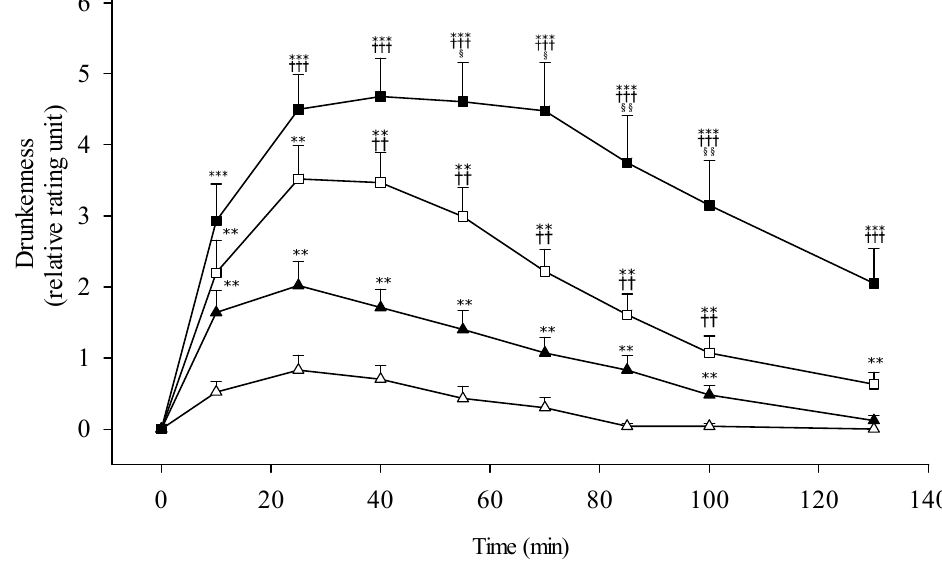
Figure 5. Feelings of drunkenness in nonalcoholic subjects with different ALDH2 allelotypes following different doses of ethanol (0.3 g/kg body weight or 0.5 g/kg). All subjects are ADH1B*2/*2 homozygote. The study groups are denoted as △ , ALDH2*1/*1 with 0.3 g/kg ethanol ( n = 23); ▲ , ALDH2*1/*1 with 0.5 g/kg ethanol ( n = 21); □ , ALDH2*1/*2 with 0.3 g/kg ethanol ( n = 27); ■ , ALDH2*1/*2 with 0.5 g/kg ethanol ( n = 22). Vertical bars (for clarity only the upper or lower portion shown) represent standard errors of the mean. Statistically significant differences between groups at the corresponding time points was evaluated by ANOVA. *** p < 0.001, ** p < 0.01 vs. ALDH2*1/*1 with 0.3 g/kg ethanol; +++ p < 0.001, ++ p < 0.01 vs. ALDH2*1/*1 with 0.5 g/kg ethanol; §§ p < 0.01, § p < 0.05 vs. ALDH2*1/*2 with 0.3 g/kg ethanol. Figure 6. The participants with ALDH2*2 heterozygote revealed more negative psycholog- ical responses than those with ALDH2*1/*1 homozygote. There were stronger reactions during the entire test period in the 0.5 g/kg testing dose group. Apart from the physiologi- cal negative reactions, a modest increase of positive sensation in the ALDH2*1/*2 group was noticed; however, they did not show the statistical significance among groups with different alcohol dose ingestion (Figure 6). The ADH1B*2/*2 – ALDH2*1/*1 subjects, following